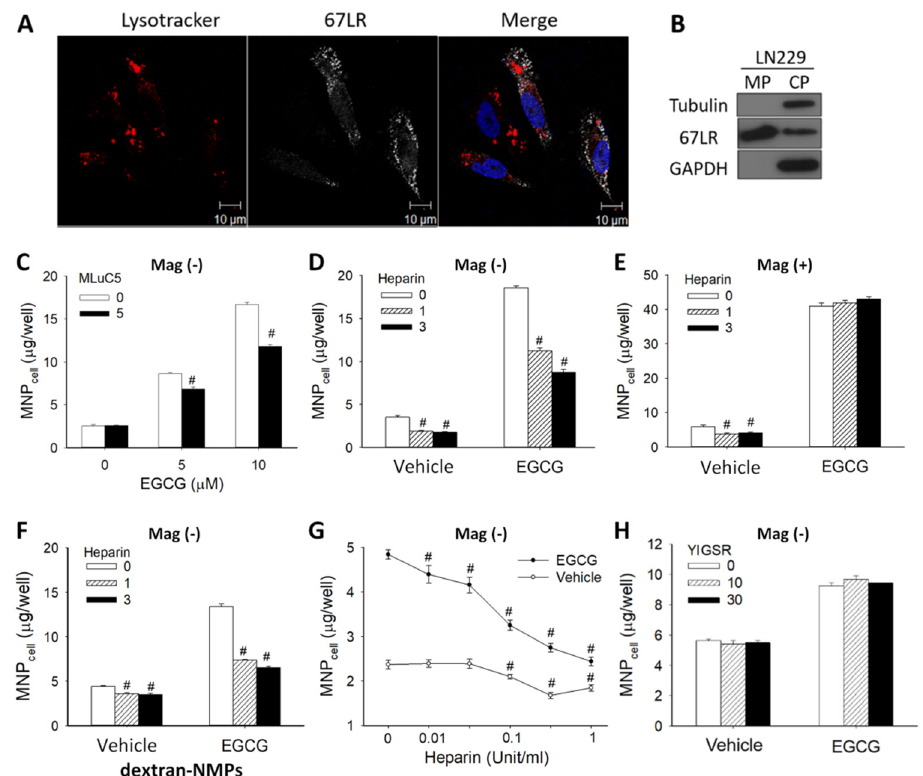
Figure 3. Anti-67LR antibody and heparin, but not YIGSR, blocked EGCG-induced MNP uptake in the absence of the magnet. ( A ) Lysosomes (red), 67LR (white), and nuclei (blue) of LN-229 cells were stained and observed with confocal microscopy. ( B ) Expressions of tubulin, 67LR, and GAPDH in the fractions of membrane (MP, 0.6 μ g protein) and cytoplasm (CP, 20 μ g protein) were determined by western blot. After pretreatment with anti-67LR antibody (MLuC5, 5 μ g/mL; ( C )), heparin (0.01–3 Unit/mL; ( D – G )) or YIGSR (10 or 30 μ g/mL; ( H )), LN-229 cells were incubated with 50 μ g/well of CMX-MNPs ( C – E , G , H ) or dextran-MNPs ( F ) in the presence of EGCG (5 or 10 μ M) or vehicle for 2 and 6 h, respectively. The incubation was conducted in the absence (Mag − ; ( C , D , F – H )) or presence (Mag+; E ) of the magnet. The results are representative of 4 experiments with different batches of cells; values are presented as mean ± SEM ( n = 4). # , p < 0.05 compared with the corresponding group without MLuC5 or heparin.